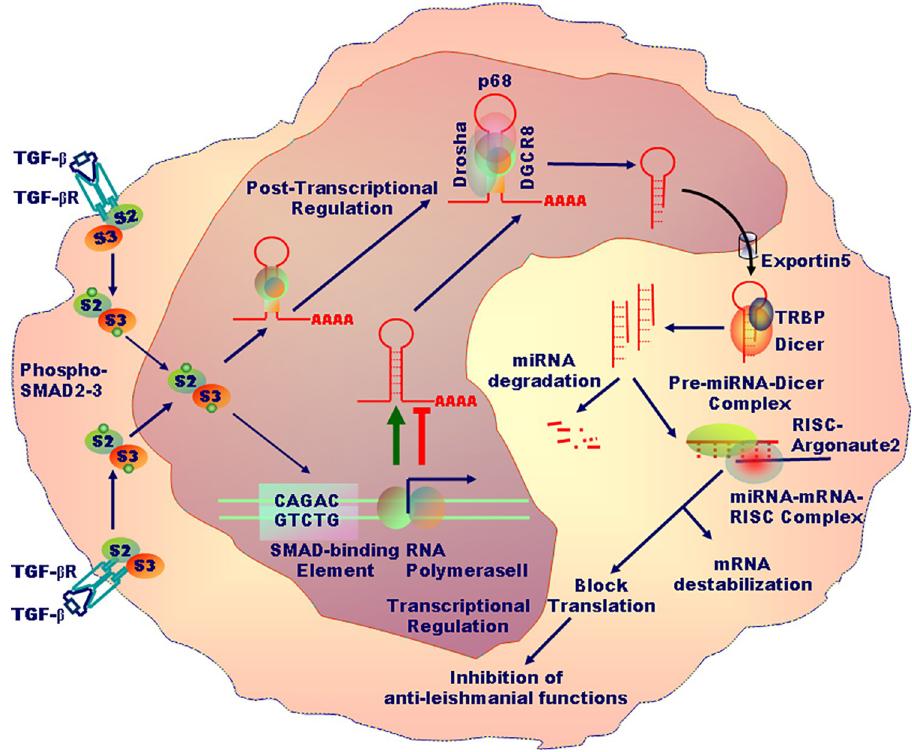
Fig 3. TGF- β induced by Leishmania infection binds to TGF- β receptor causing its phosphorylation and subsequent SMAD2/SMAD3-dependent transcriptional and posttranscriptional regulation of miRNA expression in macrophages. These miRNAs make complexes with the target mRNAs—one miRNA binding to many mRNAs—to destabilize or suppress mRNAs translation. Depending on the miRNAs up-regulated or down-regulated, proleishmanial or antileishmanial effects are observed. miRNA,